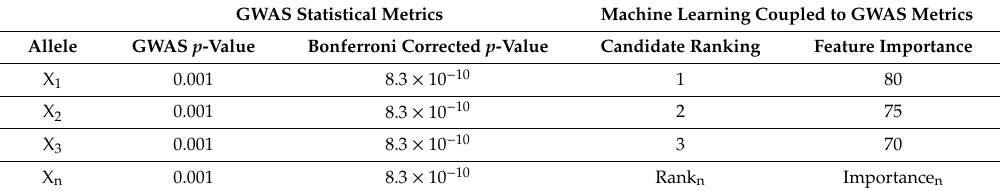
Table 1. Exemplar comparison of statistical metrics of genome-wide association study (GWAS) versus machine learning metrics. Allelic variant association with phenotype using XGBoost. An allele can be very large, ~8000 for porA for a pairwise comparison. Using a population of this gene from 200 genomes created a population variation of 1.2 million variants that can be ranked with an estimation of importance to association with the disease phenotype, abortion in this